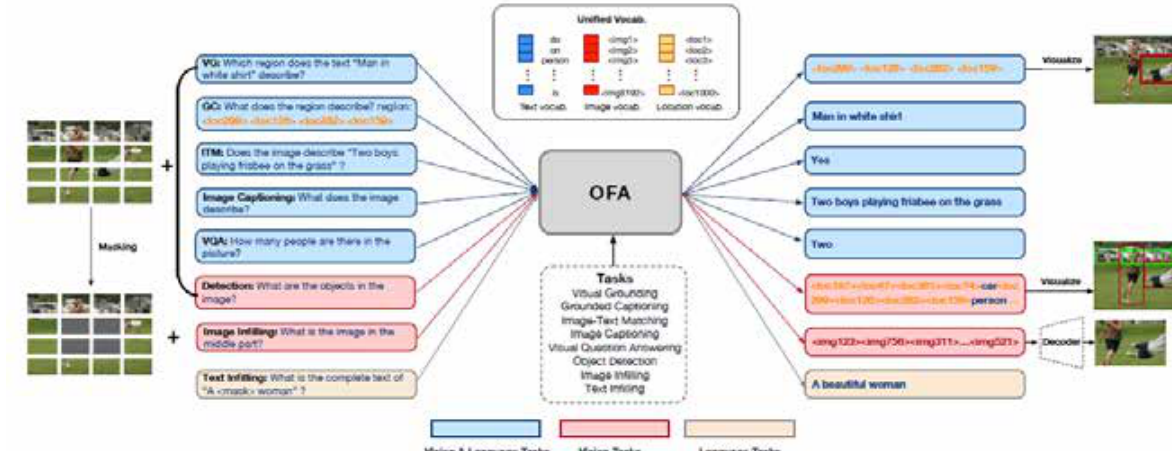
Figure 10 M6-OFA pre-training task [34].